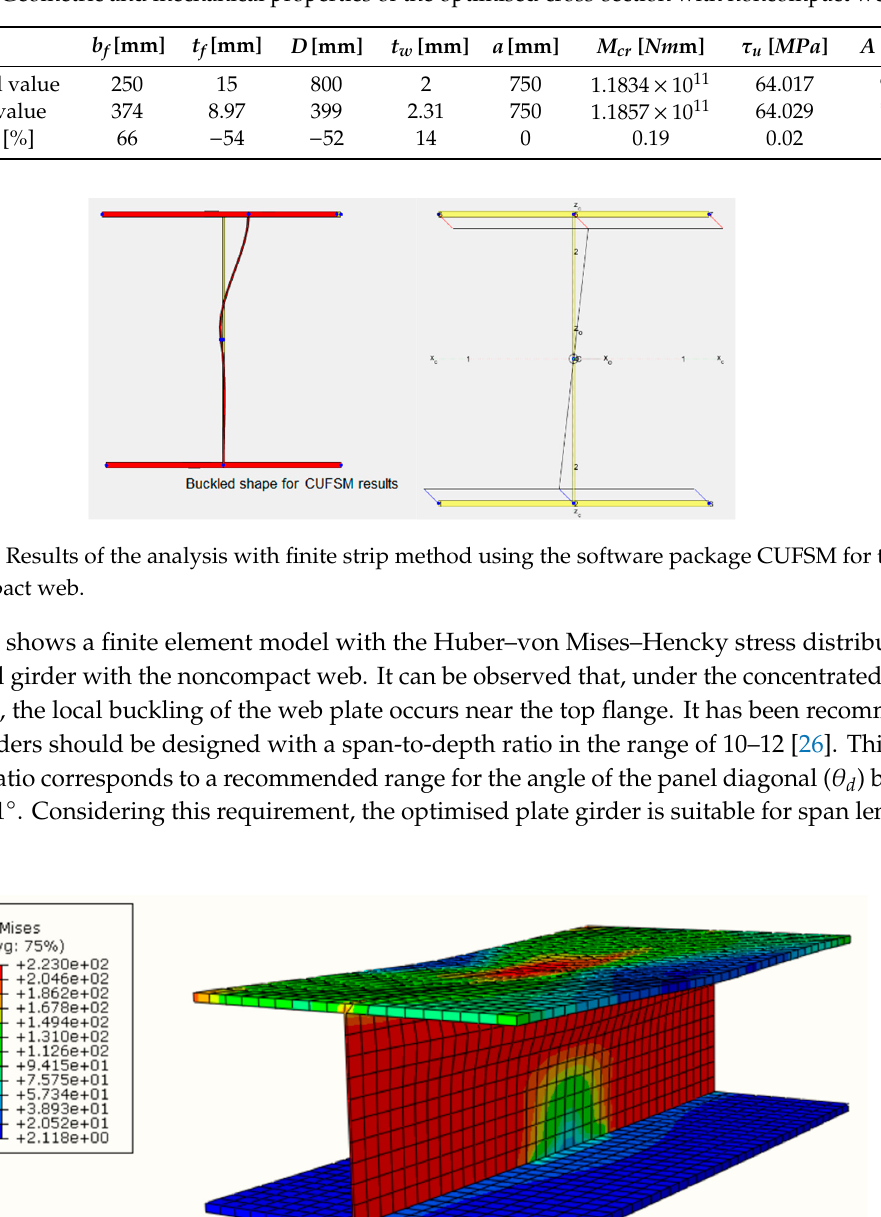
Table 4. Geometric and mechanical properties of the optimised cross-section with noncompact web.